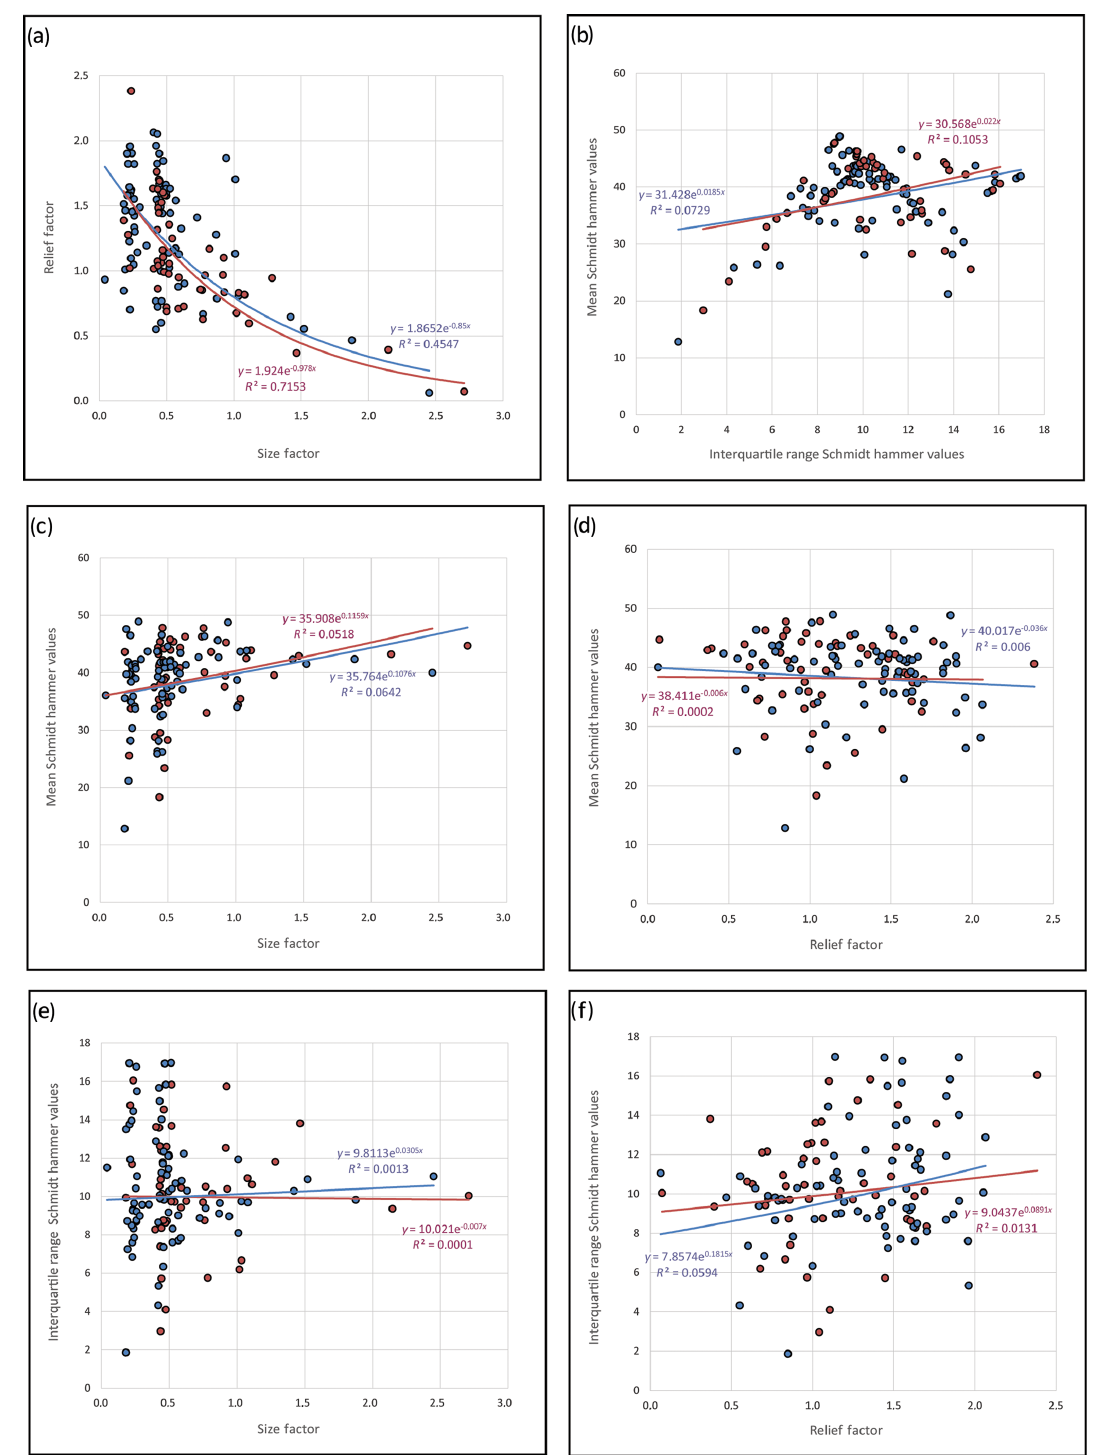
Figure 6. Graphics show relationship between different studied factors in catchments with debris flow generation in red and nongeneration in blue. (a) Relationship between size factor and relief factor. (b) Relationship between mean and interquartile range of Schmidt hammer values. (c) Relationship between mean Schmidt hammer values and size factor. (d) Relationship between mean Schmidt hammer values and relief factor. (e) Relationship between interquartile range of Schmidt hammer values and size factor. (f) Relationship between interquartile range of Schmidt hammer values and relief